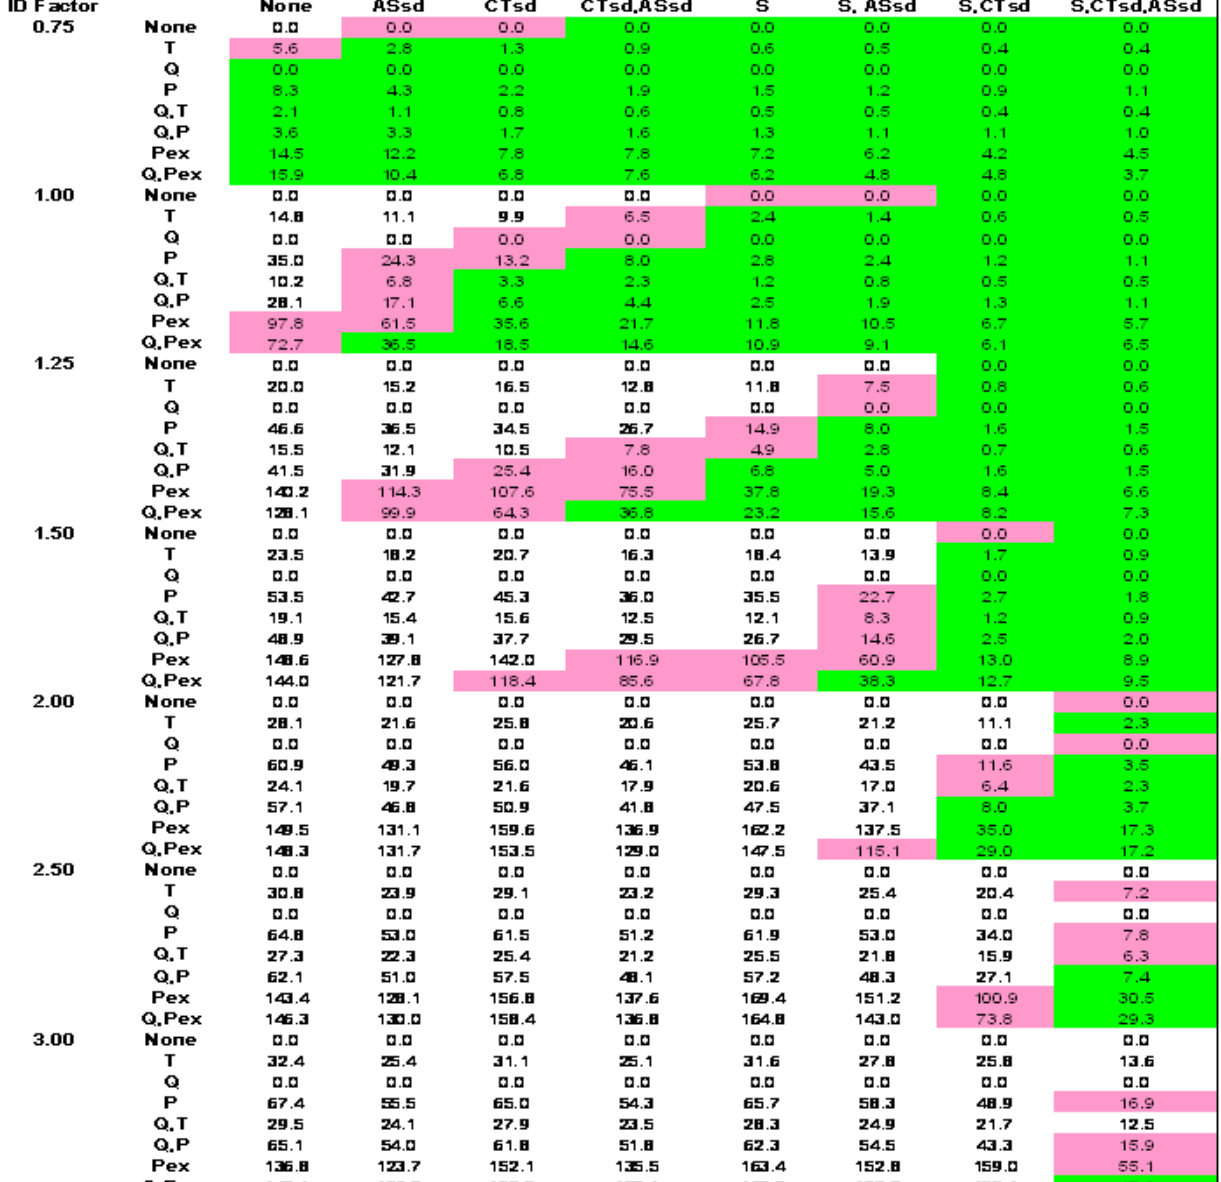
Figure 1, I F 1.5 region, shows that a quarter of the strategies yield results with , 10 percent infected (green). However, implementing all case-based interventions without network-based interventions can result, at best, in an infection rate of 35 percent (also see Figure 4b ). Implementing all network-based interven- tions alone can reduce the infection rate to 5 percent (also see Figure 4c ). The nonlinearity in the combination of social distancing interventions is of note. S or CTsd alone are not very